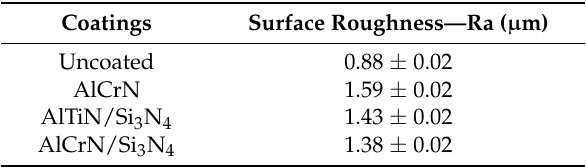
Table 3. The surface roughness of the